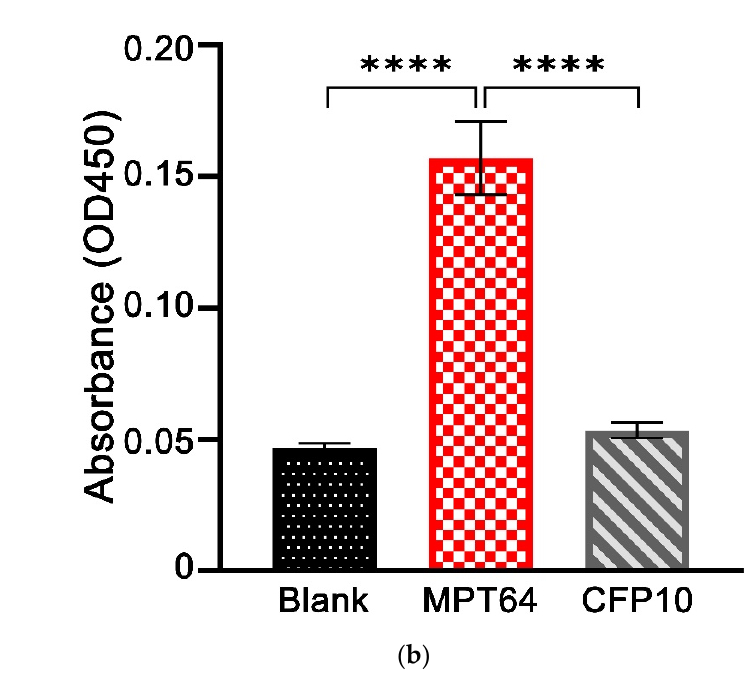
Figure 2. ( a ) A 2D structure of the MPT64 aptamer was predicted with the Mfold program. ( b ) The binding affinity of the MPT64 aptamer to the MPT64 target antigen. The binding ability of aptamer to MPT64 was compared with aptamer-alone control and the non-target CFP10 antigen. Statistical analysis was performed using the post hoc Tukey test. Data are presented as the mean of triplicate ± SD, **** denotes p < 0.0001.